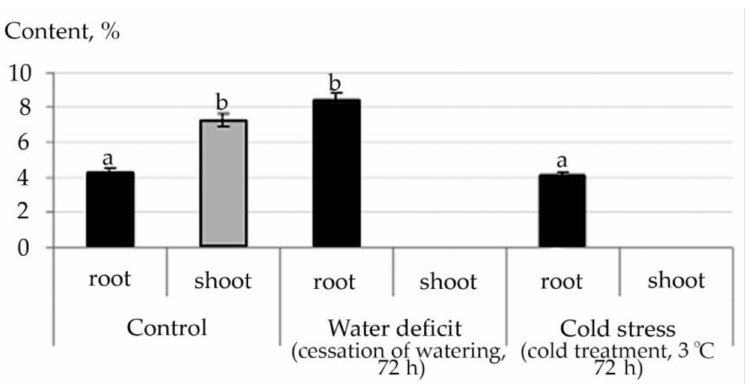
Figure 9. Change in the content of 2-Hydroxy-gamma-butyrolactone in R. semenowii under stress conditions. Values presented are means ( ± SD). Different letters above the bars represent significant differences at p ≤ 0.05, n = 3 plants in each of 3 replicates for all